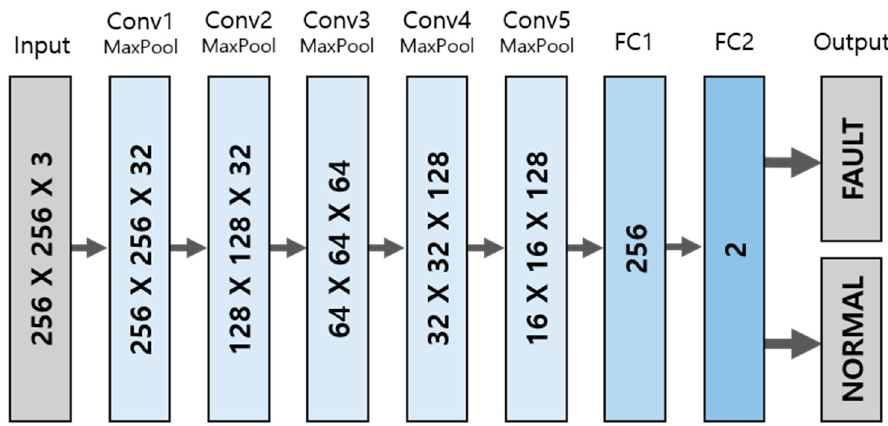
Figure 9. The architecture of CNN model for fault detection.